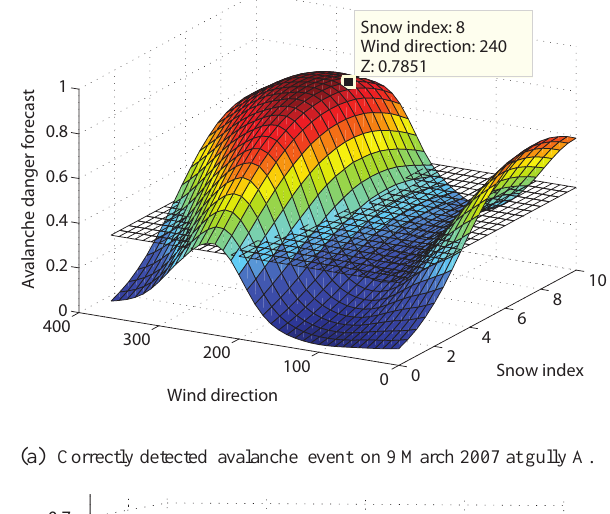
Fig. 6. Behavior of the model dealing with changing Wind direction and Snow index at the selected gullies. The decision threshold t is represented by the gridded black plane at a height of 0.37.